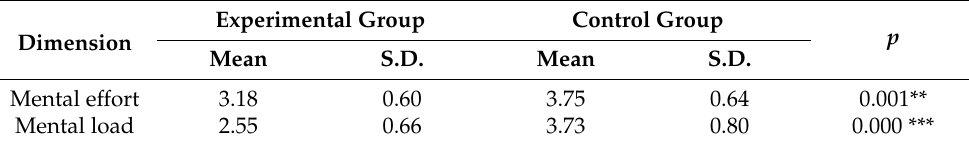
Table 6. Dimensional analysis on cognitive load for both groups. Dimension